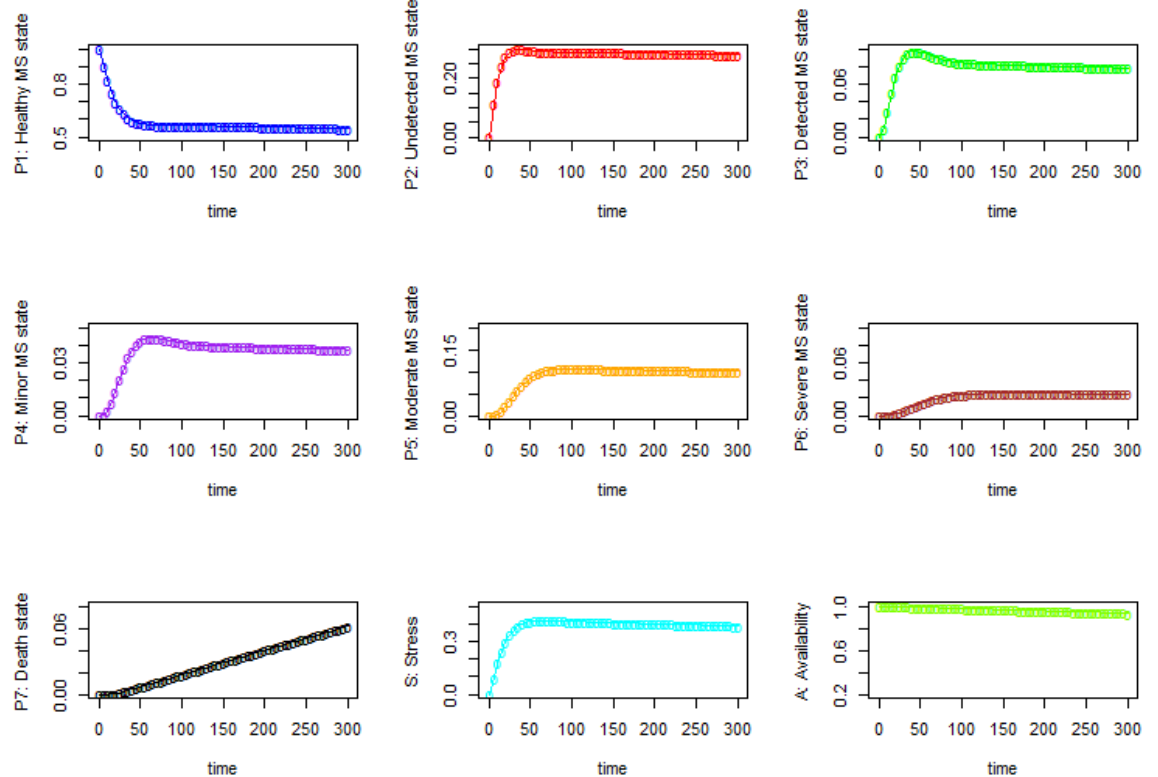
Figure 4. The probability results of each state where the initial probability is P 1 (0) = 1. Case 2: k = 0.01, v = 0.002, and w = 0.00035